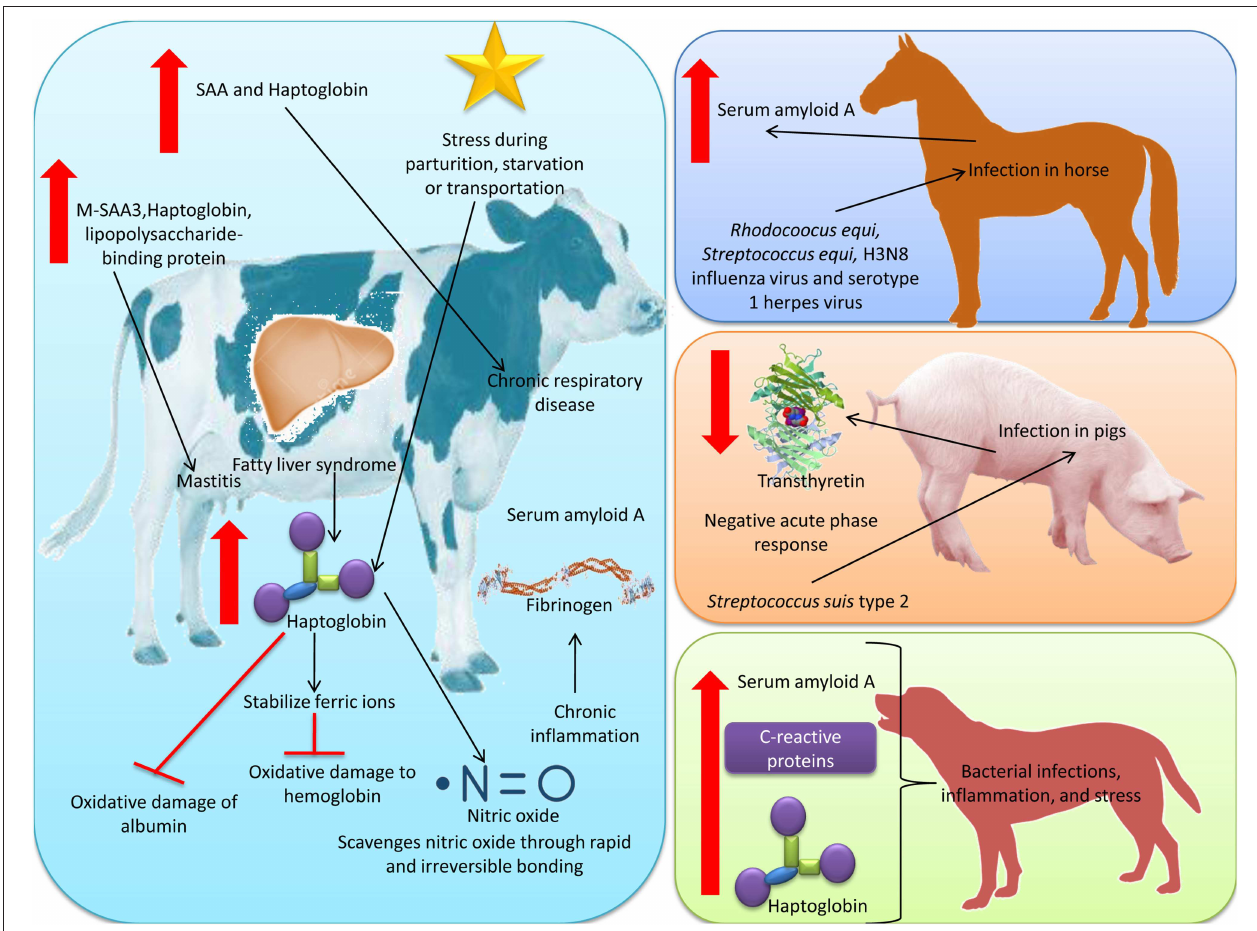
FIGURE 3 | Acute phase proteins as stress biomarkers. Increased level of haptoglobin was noticed in cattle in conditions like fatty liver syndrome and stress induced by parturition, starvation, or transportation. There was also increase in SAA and fibrinogen in cattle during chronic inflammation and associated stress. Haptoglobin exerts its anti-oxidant role by stabilizing ferric irons to prevent oxidative damage to hemoglobin. Haptoglobin protects albumin from oxidative damage by inhibiting the exchange of heme between hemoglobin and albumin. Haptoglobin scavenges nitric oxide through rapid and irreversible bonding, thereby limiting its bioavailability and preventing oxidative damage from reactive nitrogen species. Haptoglobin and SAA are synthesized in the bovine mammary epithelium, and the substantial increase in their secretion into milk was observed during mastitis. SAA has been found to increase in sera of foals during infections with bacteria, i.e., Rhodocoocus equi and Streptococcus equi and viruses, i.e., H3N8 influenza virus and serotype 1 herpes virus. Streptococcus suis type 2 infection in pigs, transthyretin showed a negative acute phase response. CRP is the primary APP in canines, along with haptoglobin and SAA, whose concentrations are elevated in bacterial infections, inflammation, and